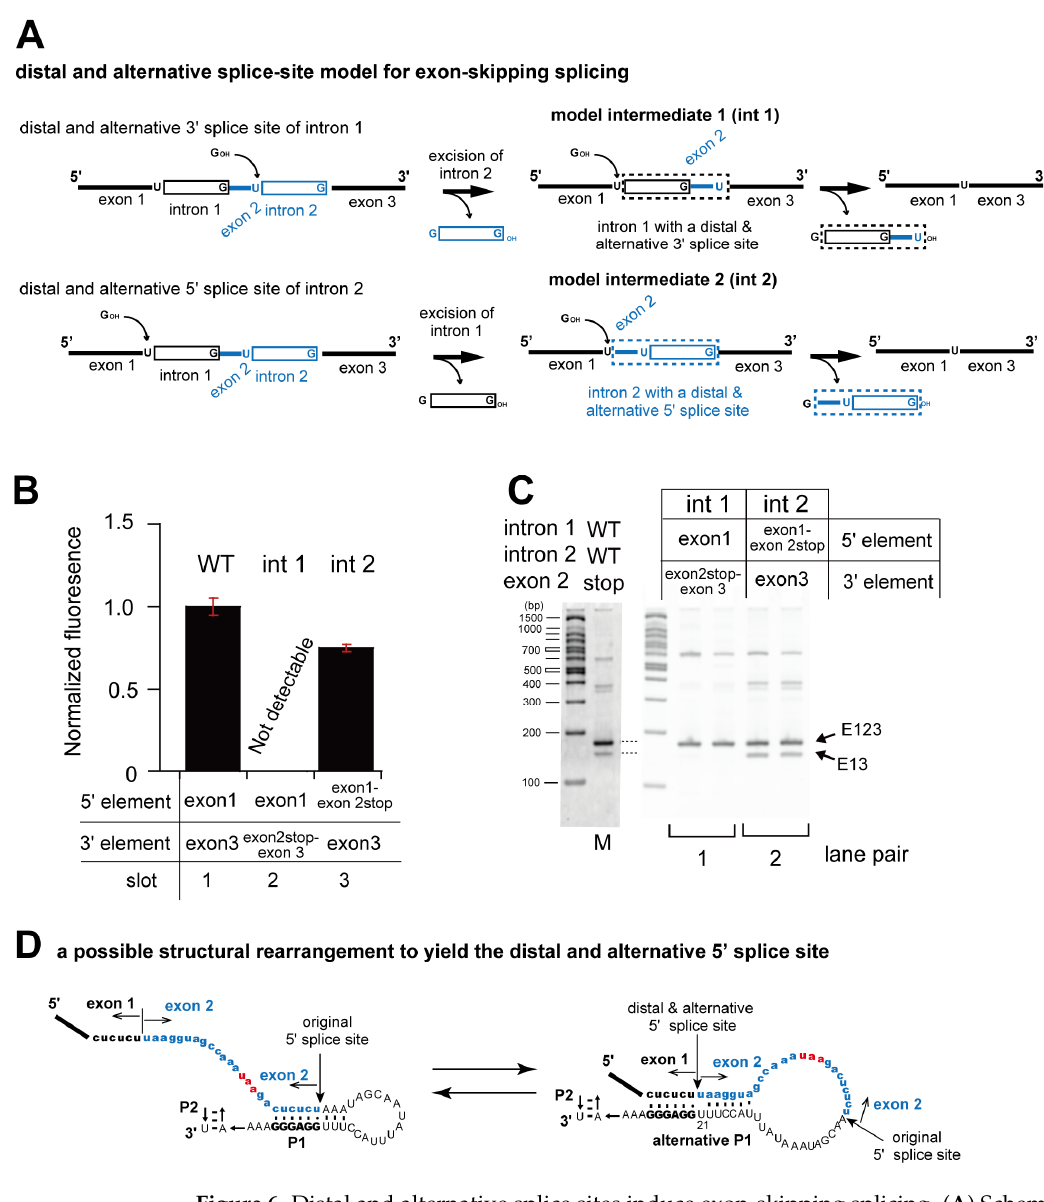
Figure 6. Distal and alternative splice sites induce exon-skipping splicing. ( A ) Schematic represen- tations of distal and alternative splice-site models for exon-skipping splicing. ( B ) β-Galactosidase reporter gene assays of model intermediates to evaluate their use of distal and alternative splice sites to yield the ligated exons lacking exon 2 in E. coli . ( C ) RT-PCR assays to distinguish the ligated exons (E123 or E13) including or skipping exon 2, with lengths of 174 and 150 bp, respectively. ( D ) A possible structural rearrangement to yield the distal and alternative 5 (cid:48) splice